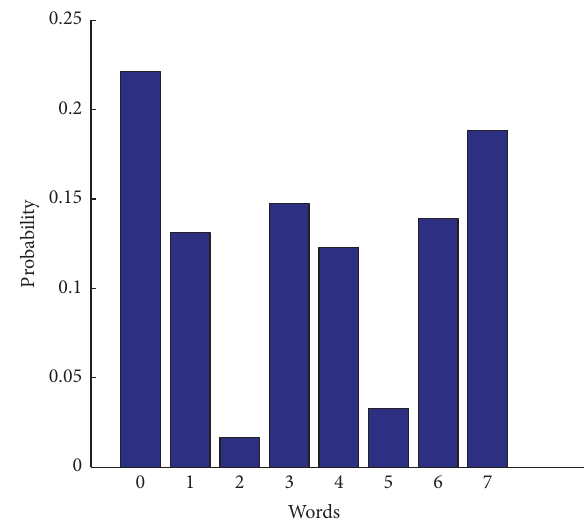
Figure 3: Probability of each